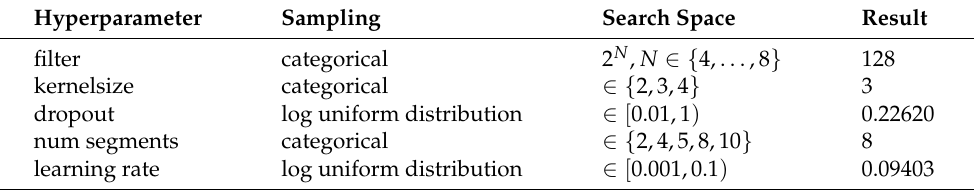
Table 7. Model parameters and hyperparameters, search space and optimization results for the convLSTM